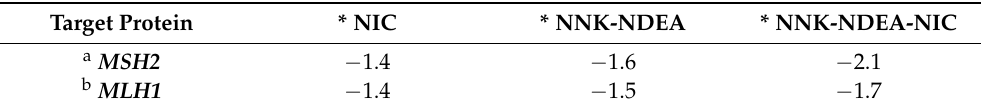
Table 2. Chronic exposure to TS components causes a decrease of MLH1 and MSH2 in premalignant murine hypopharyngeal